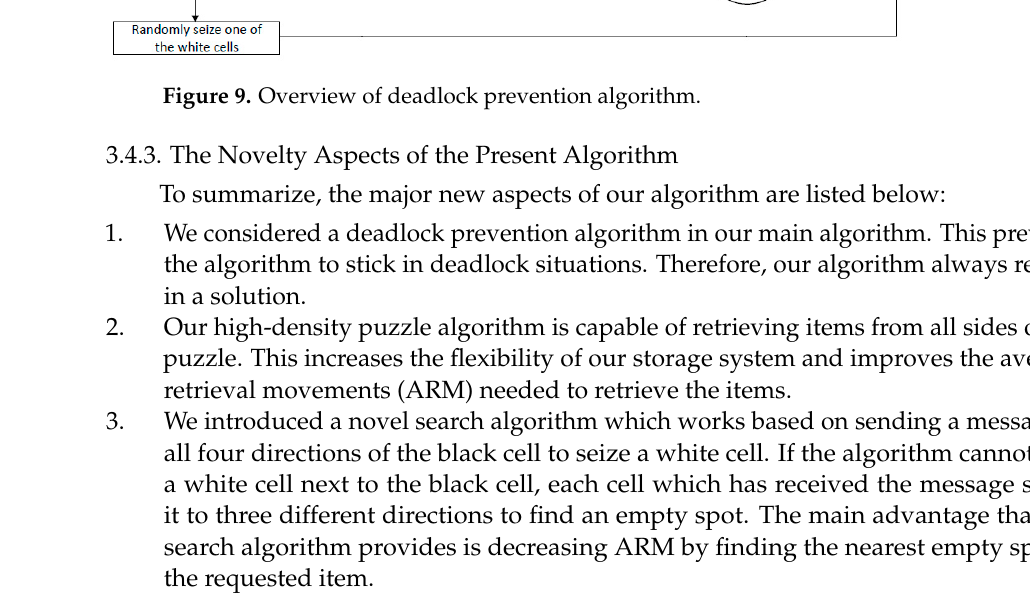
Figure 9. Overview of deadlock prevention algorithm.